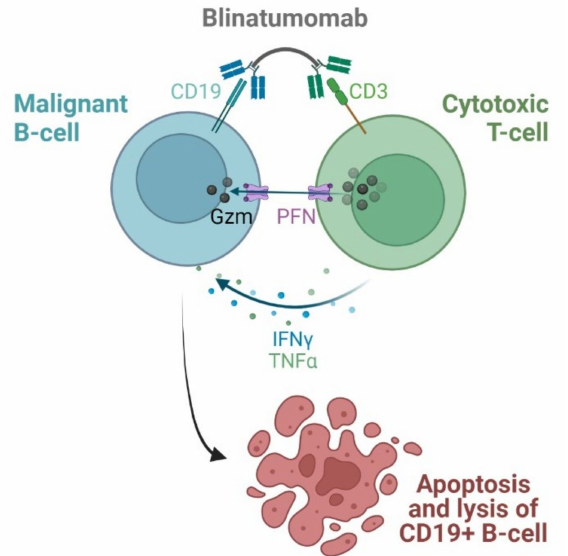
Figure 10. Blinatumomab mechanism of action. CD19 : cluster of differentiation 19. CD3 : cluster of differentiation 3. Gzm : granzymes. PFN: perforin. IFN γ : interferon gamma. TNF α : tumor necrosis factor alpha. Created with